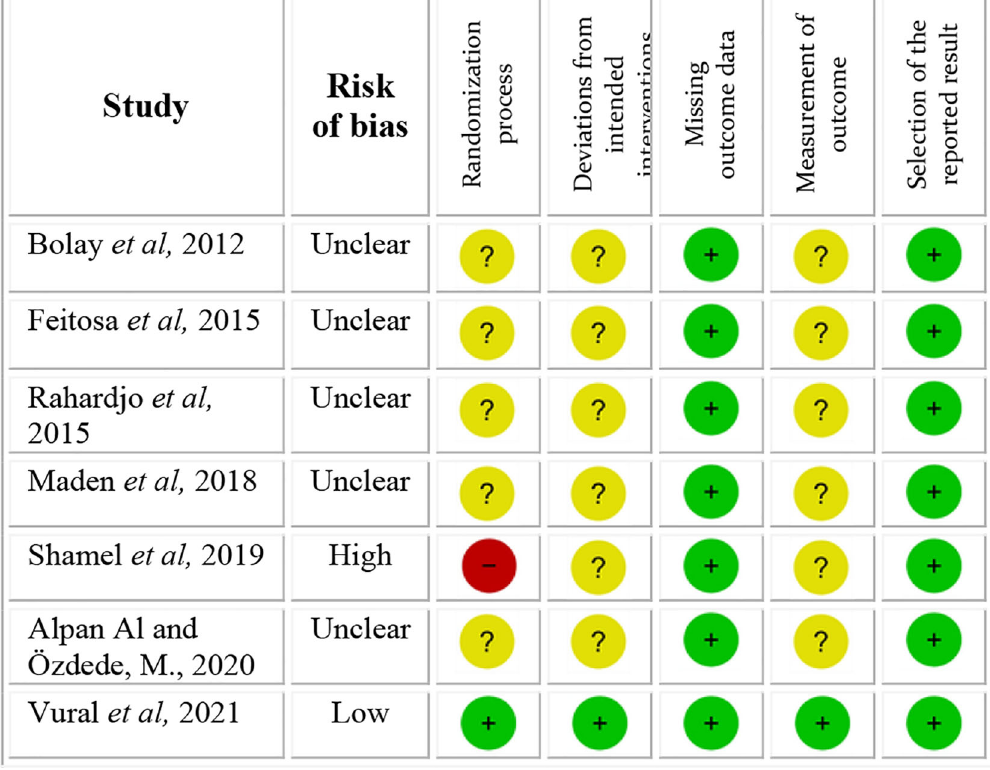
Figure 2. Risk of bias